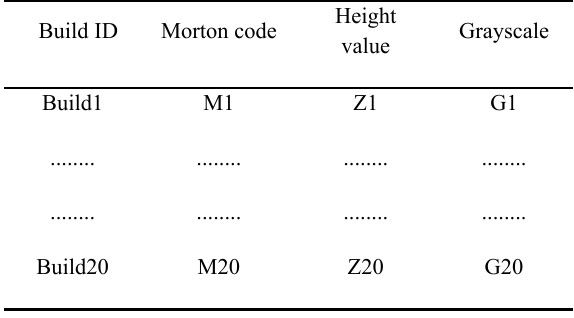
Table 6. Data structure table represented by the green area